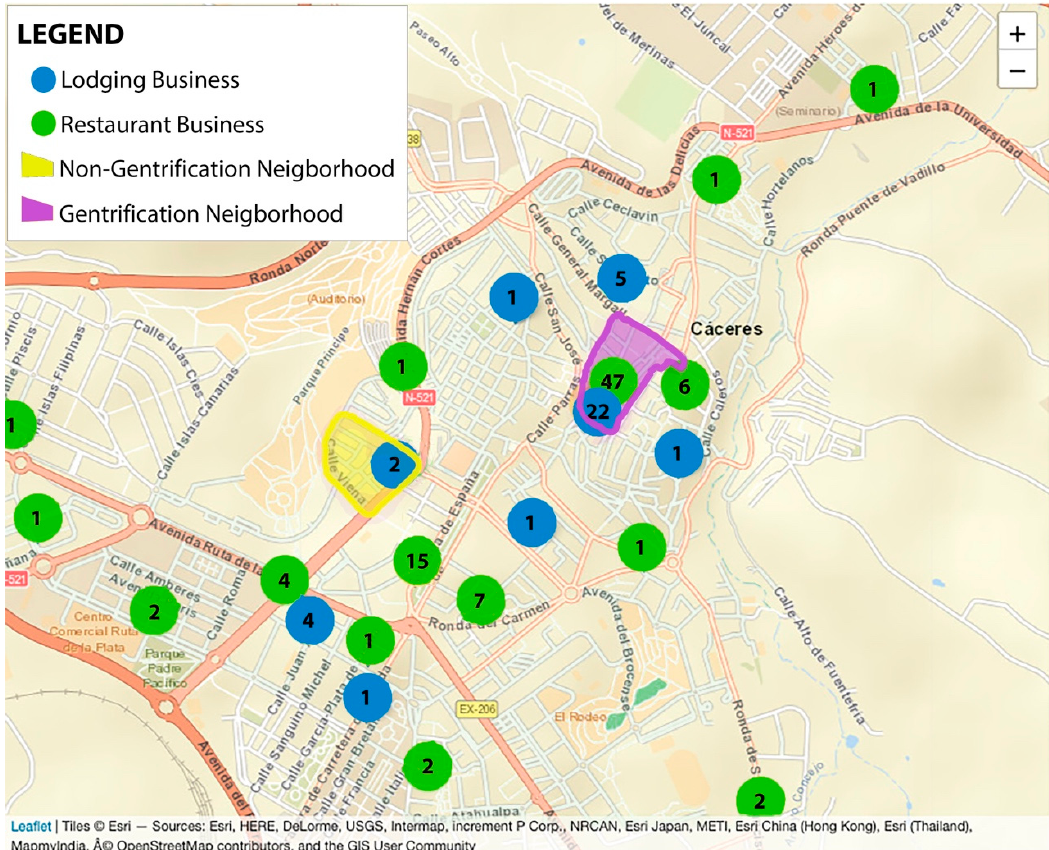
Figure 2. Represention of the gentrified neighborhood (GN) and non-gentrified neighborhood (NGN) and a number of tourist establishments.